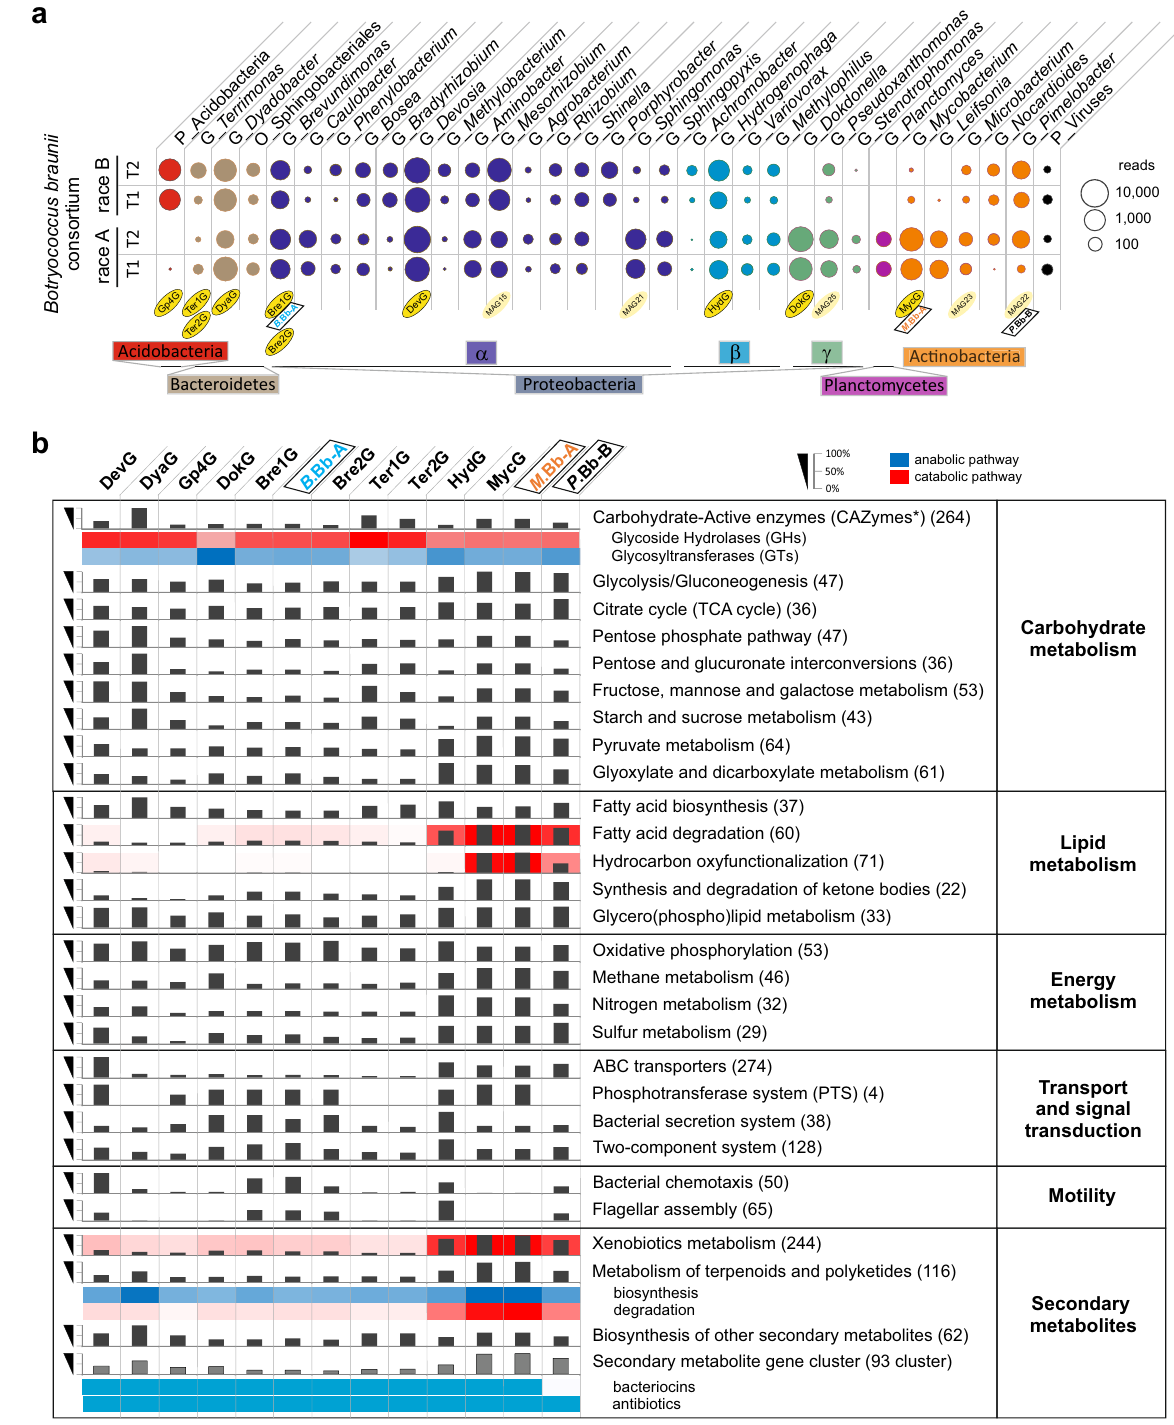
Figure 1. Taxonomy of the B. braunii bacterial community and selected functional categories encoded in reconstructed MAGs and complete genomes. ( a ) Normalized read-based comparison and taxonomic assignment of different B. braunii metagenome datasets. The circle size represents the amount of classified reads for the respective taxonomic group (minimum 50 reads per taxonomic group). Abbreviations: P, phylum; G, genus; O, order. ( b ) Abundance of selected functional categories encoded in the high-quality draft and complete bacterial genomes. Numbers in parentheses represent the maximal total number of genes within each pathway. Percentage: per cent of total number of genes per pathway identified within each genome. All annotated genes within the respective pathways are presented on the EMGB platform (https ://emgb.cebit ec.uni-biele feld.de/ Bbrau nii-bacte rial-conso rtium /). The pathways statistics are summarized in the Table